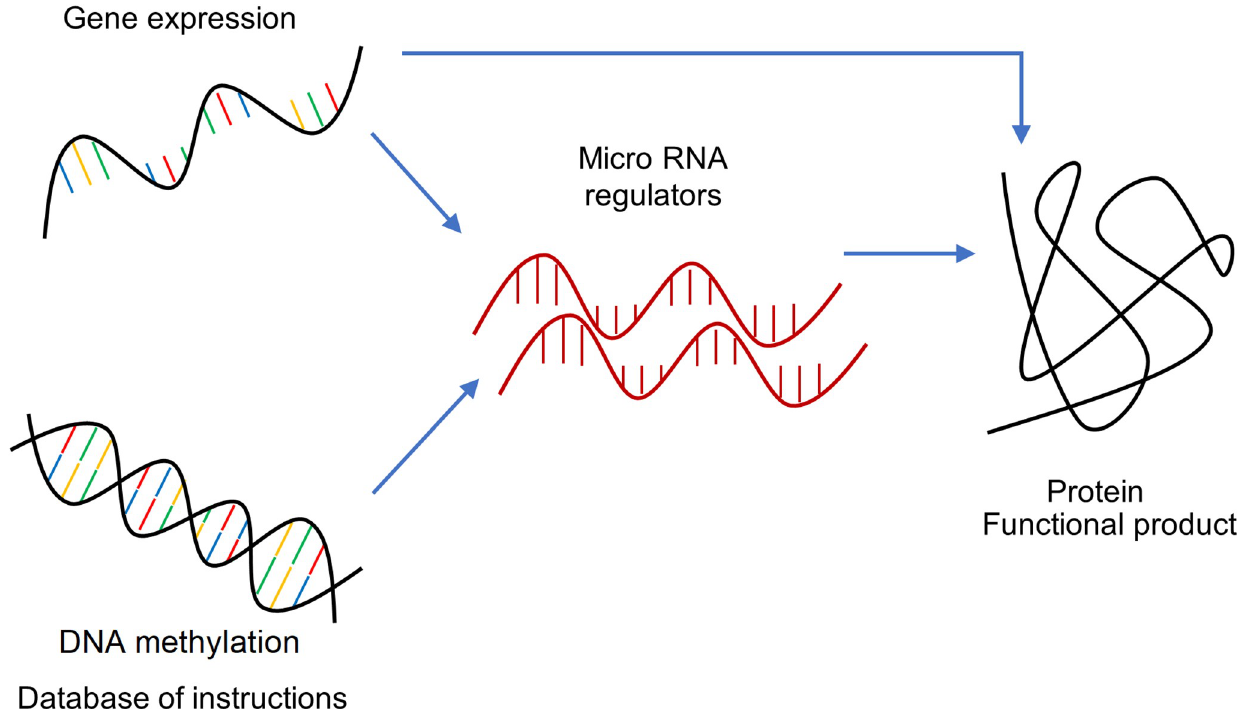
Fig 2. The central dogma of molecular biology. Directional dependencies among biological